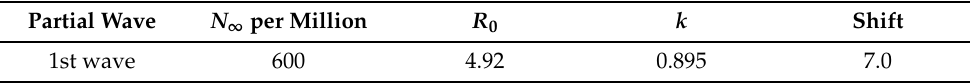
Figure 1. The logarithmic plot of the epicurve for the Alpha surge in COVID-19 in Taiwan from May to July 2021. ( a ) The reported cases per million people and the fitted results (solid curve). The fit was performed with a single partial wave denoted by dashed lines. ( b ) The observed data and the fitted result of the K-value. The red bands stand for the systematic errors in the choice of the fitted range of the partial wave. Table 1. The parameters of the Gompertz curves for the Alpha surge in Shanghai. The N ∞ , R 0 , and k are the cumulative number of infected people, the basic reproduction number, and the connected probability of transmission links, respectively. The “Shift” stands for the onset of the Gompertz curves from the reference date (5 May